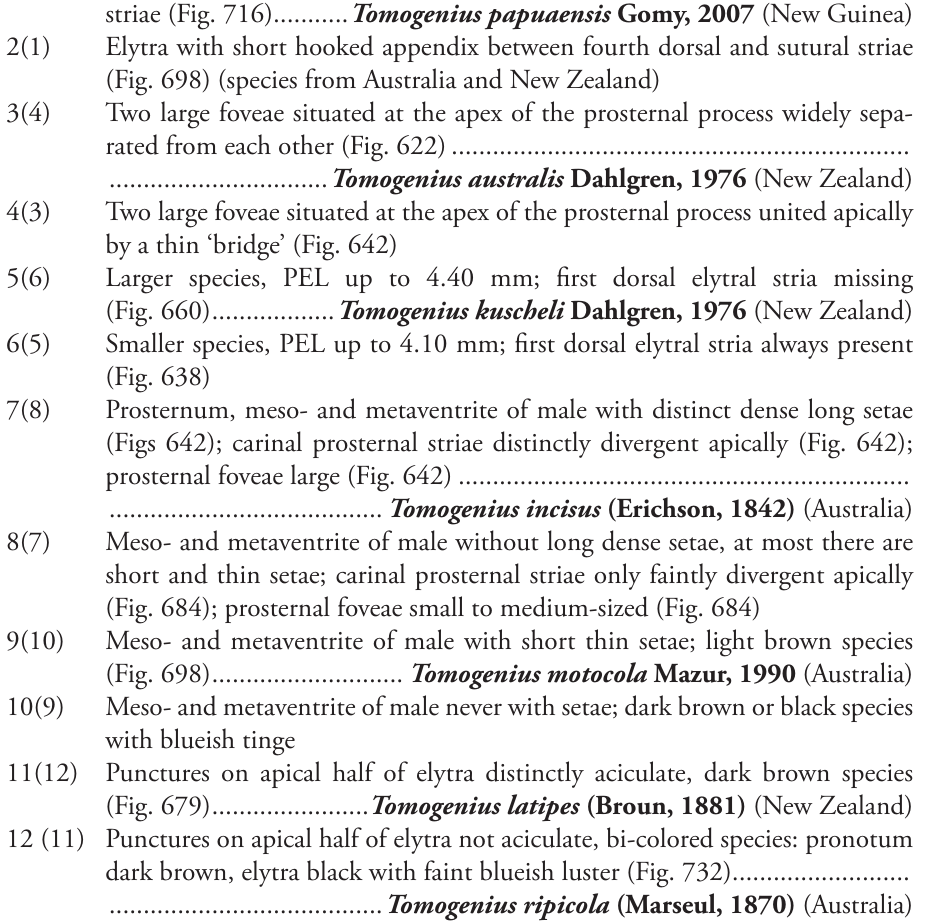
Meso- and metaventrite of male without long dense setae, at most there are short and thin setae; carinal prosternal striae only faintly divergent apically (Fig. 684); prosternal foveae small to medium-sized (Fig. 684) 9(10) Meso- and metaventrite of male with short thin setae; light brown species 10(9) Meso- and metaventrite of male never with setae; dark brown or black species with blueish tinge 11(12) Punctures on apical half of elytra distinctly aciculate, dark brown species (Fig. 679) ....................... Tomogenius latipes (Broun, 1881) (New Zealand) 12 (11) Punctures on apical half of elytra not aciculate, bi-colored species: pronotum dark brown, elytra black with faint blueish luster (Fig.